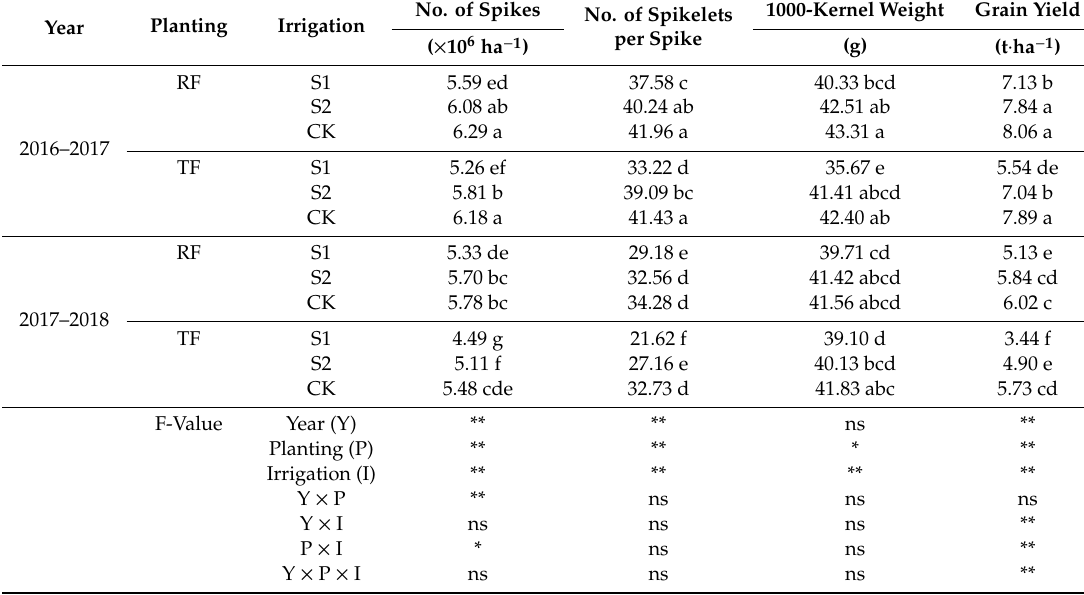
Table 2. E ff ect of two planting systems (RF and TF) and three irrigation levels (S1, S2, and CK) on the grain yield of